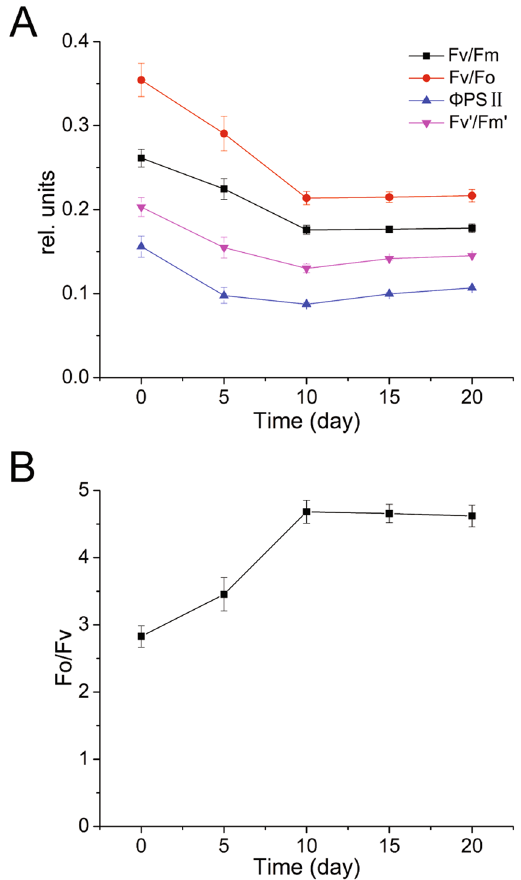
Figure 1. Changes in fluorescence parameters from slow Chl a fluorescence transients of nitrogen-starved P. cruentum . ( A ) Variation in the maximum photochemical efficiency of PSII (Fv/Fm), activity of PSII reaction centers (Fv/Fo), effective photochemical efficiency ( Φ PSII), and light-adapted maximum photochemical efficiency of PSII (Fv’/Fm’) after nitrogen deficiency. ( B ) Variation in the efficiency of the OEC of PSII (Fo/Fv) after nitrogen